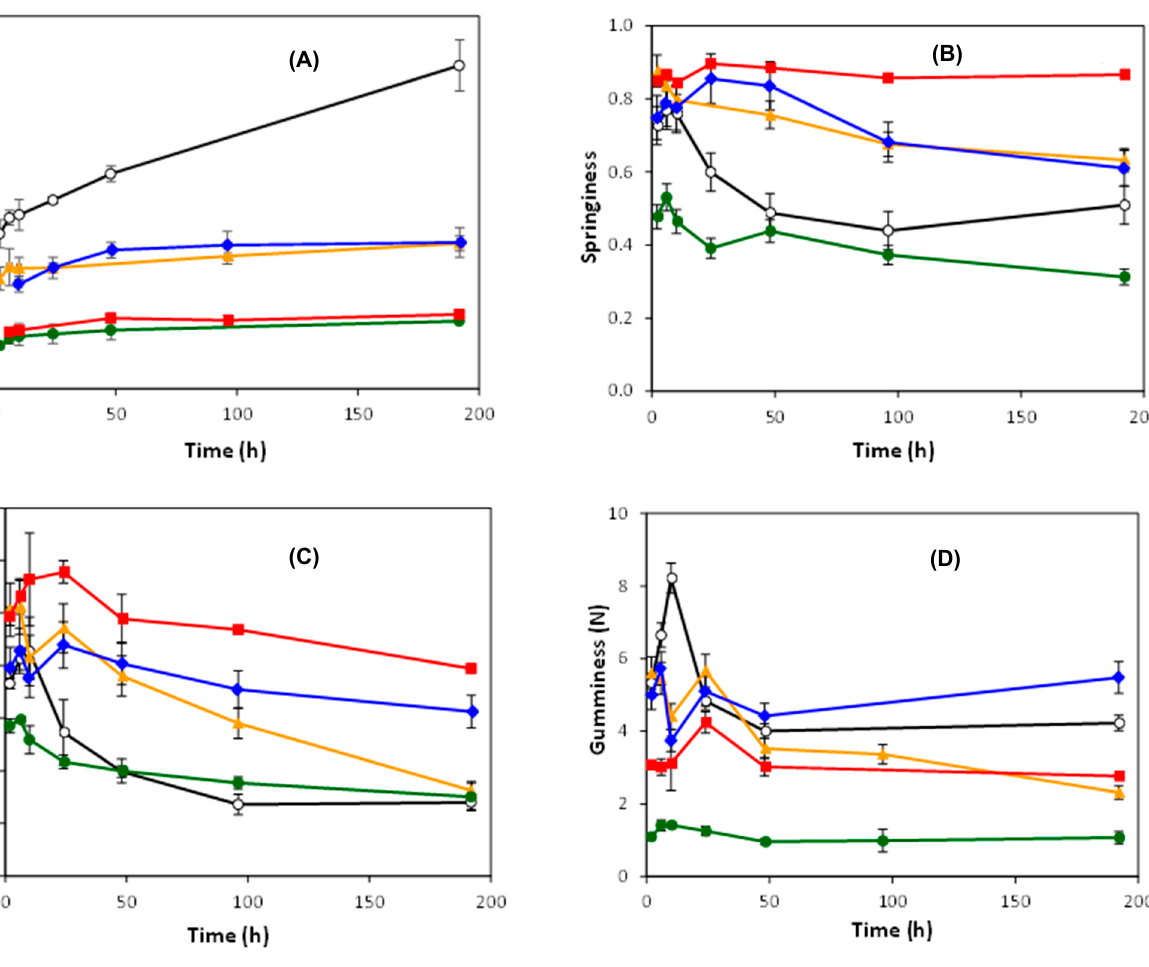
Figure 2. Evolution of firmness ( A ), springiness ( B ) cohesiveness ( C ) and gumminess ( D ) of gels made from fonio ( ), millet ( (cid:78) ), sorghum ( (cid:7) ), maize ( ) and rice ( (cid:4) ) flours at 15% concentration with the storage time at 4 ± 2 °C. The error bars represent the standard deviation.